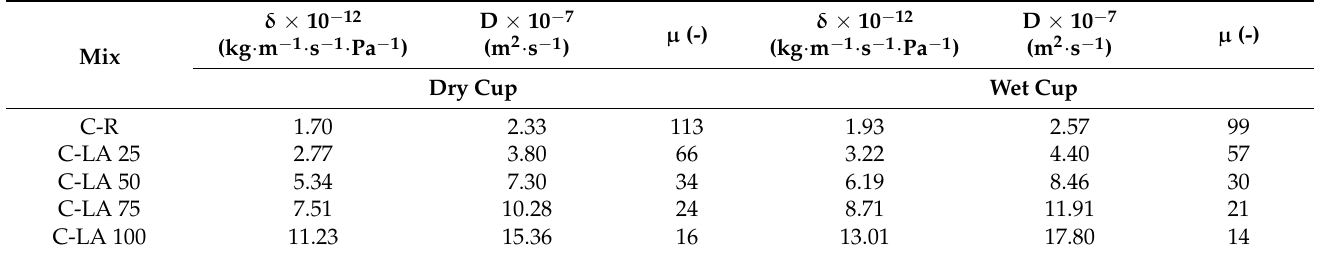
Table 7. Water vapor transmission